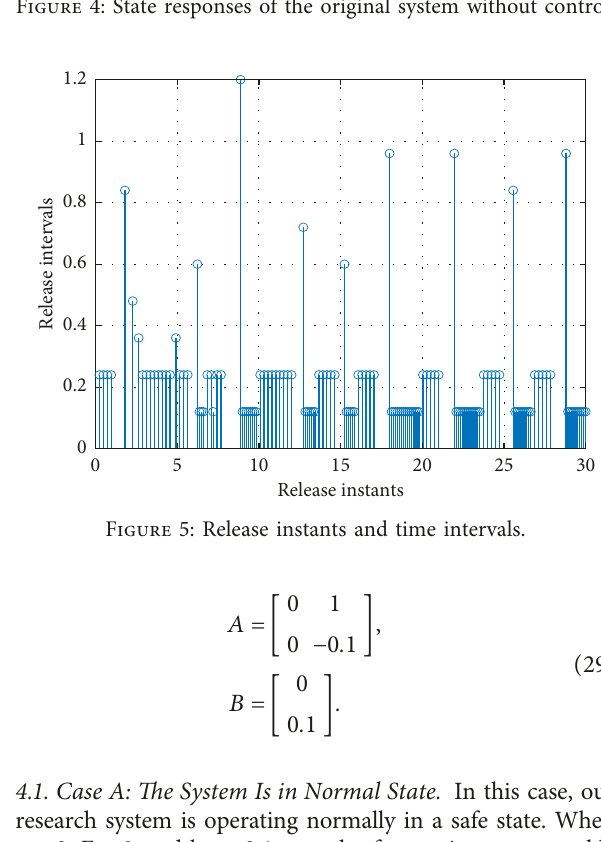
Figure 7: State responses of the original system with